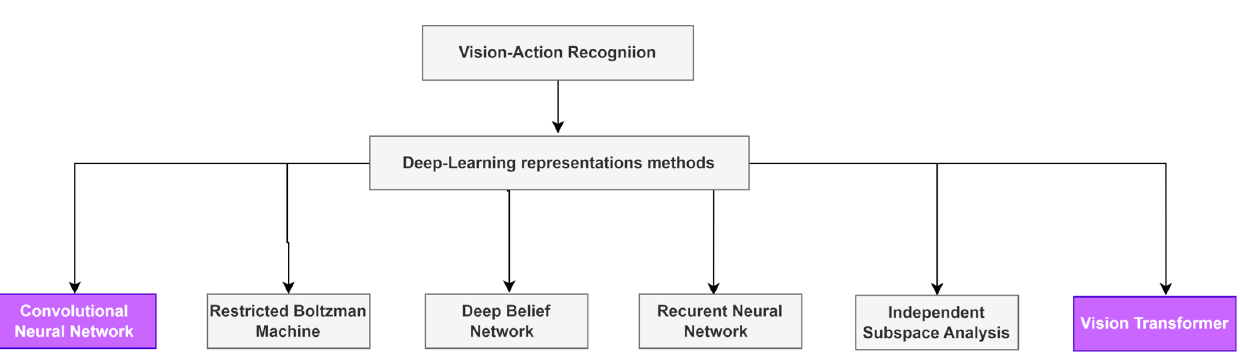
Figure 1. Different Deep Learning methods for Action Recognition.